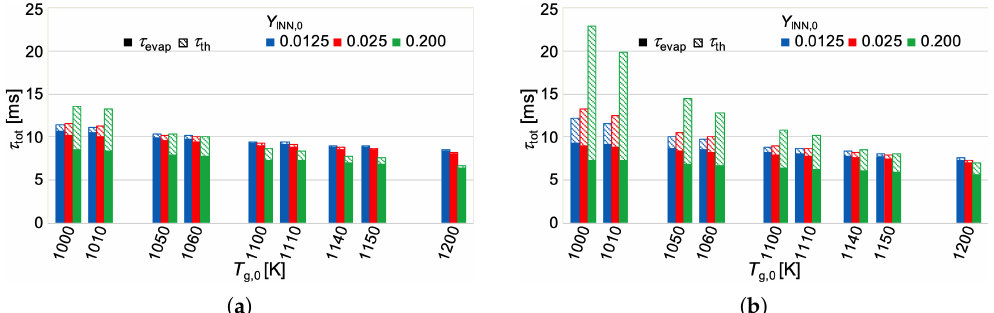
Figure 6. Contributions to the total process times for different initial INN mass fractions of 0.0125, 0.025, and 0.200. Initial conditions: r d,0 = 25 µ m, T l,0 = 293.15 K, p = 1 bar. ( a ) u 0 = 4 m/s. ( b ) u 0 = 8